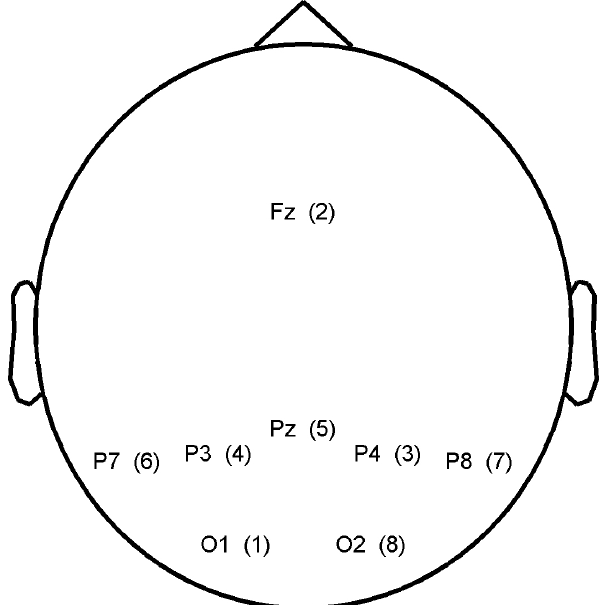
Figure 5. Electrode scores after electrode selection based on the maximization of the mean SSNR across subjects ( SS common